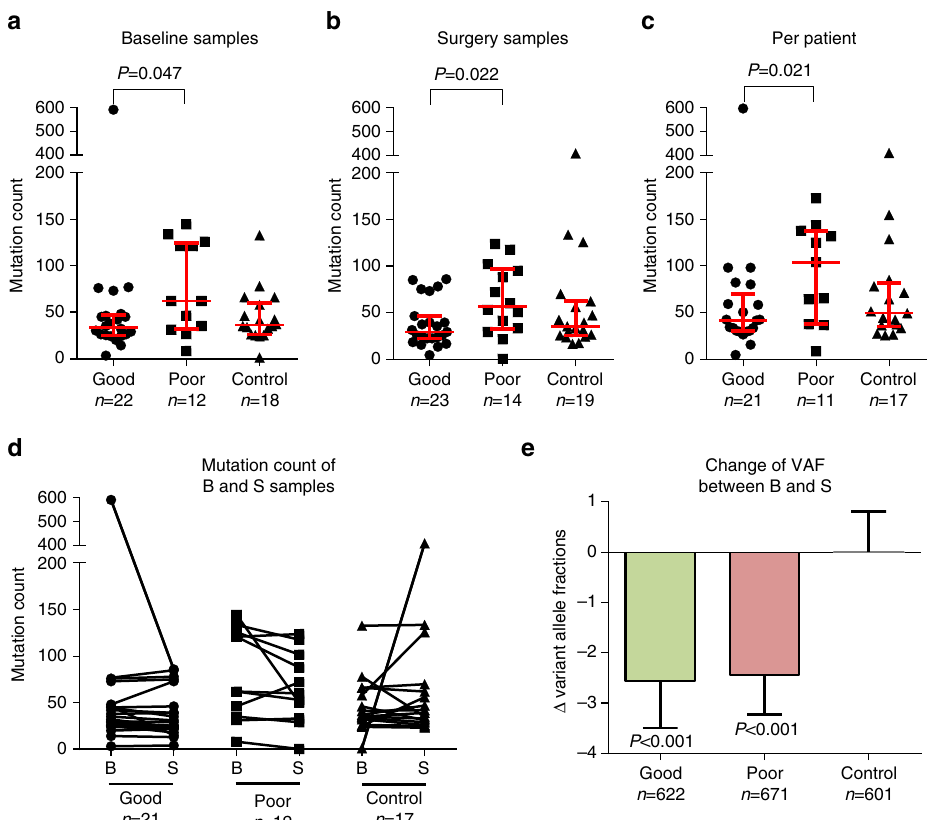
Figure 2 | Differences of mutation counts and treatment effects. Analysis on the mutation load of samples with exome-wide mutation profile from phase I. ( a – b ) Poor responder showed significantly more mutations than good responder on baseline (B) and surgery (S). ( c ) Also the number of mutations on a per-patient basis (mutations from B and S samples combined, counting identical mutations once only) was significantly higher in poor responders. Median and interquartile ranges are shown as bars. ( d ) No significant difference between the B and S mutation counts within responder groups between each of the 49 paired samples. ( e ) Good and poor responders showed a significant, but low reduction of the mean variant allele fractions (VAFs) of single-nucleotide variants between B and S. Whiskers show 95% confidence interval. Significance was tested by Mann–Whitney